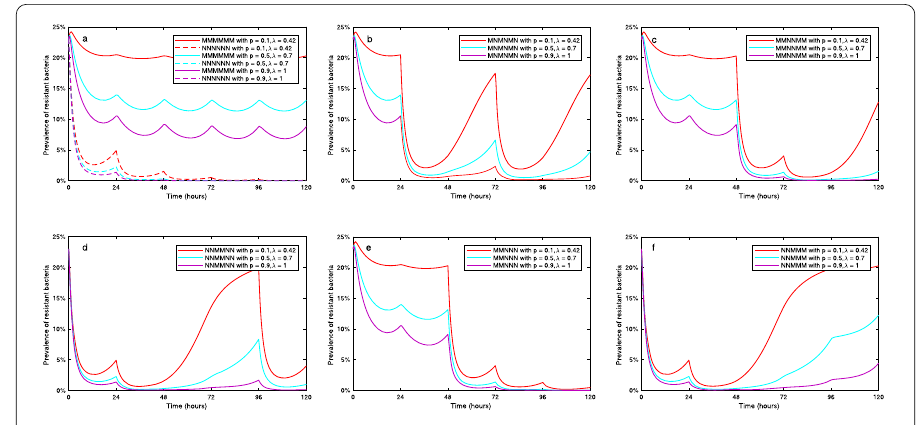
Figure 8 Characteristicofresistantbacteria . Three different characteristics of bacteria by fixing the resistance acquisition number equaling 3 are considered: (1) strain with less likelihood of losing a plasmid and horizontally transferring a plasmid p = 0.1, λ = 0.65 (red line), (2) strain with intermediate likelihood of loosing a plasmid and horizontally transferring a plasmid p = 0.5, λ = 1.05 (cyan line), and (3) strain with more likelihood of losing a plasmid and horizontally transferring a plasmid p = 0.9, λ = 1.45—purple line. ( a ) Prevalence of sensitive and resistant bacteria when the antibiotic M is administered only (solid line) and when the antibiotic N is administered only (dashed line). ( b ) Prevalence of sensitive and resistant bacteria for the one-dose antibiotic switching of M and N. ( c ) & ( d ) Prevalence of sensitive and resistant bacteria for two-dose antibiotic switching of M and N starting with M and N, respectively. ( e ) Prevalence of sensitive and resistant bacteria with two doses of M and three doses of N. ( f ) Prevalence of sensitive and resistant bacteria with two doses of N and three doses of M. ( S (0) = 1.2 × 10 8 and R (0) = 2.3 × 10 8